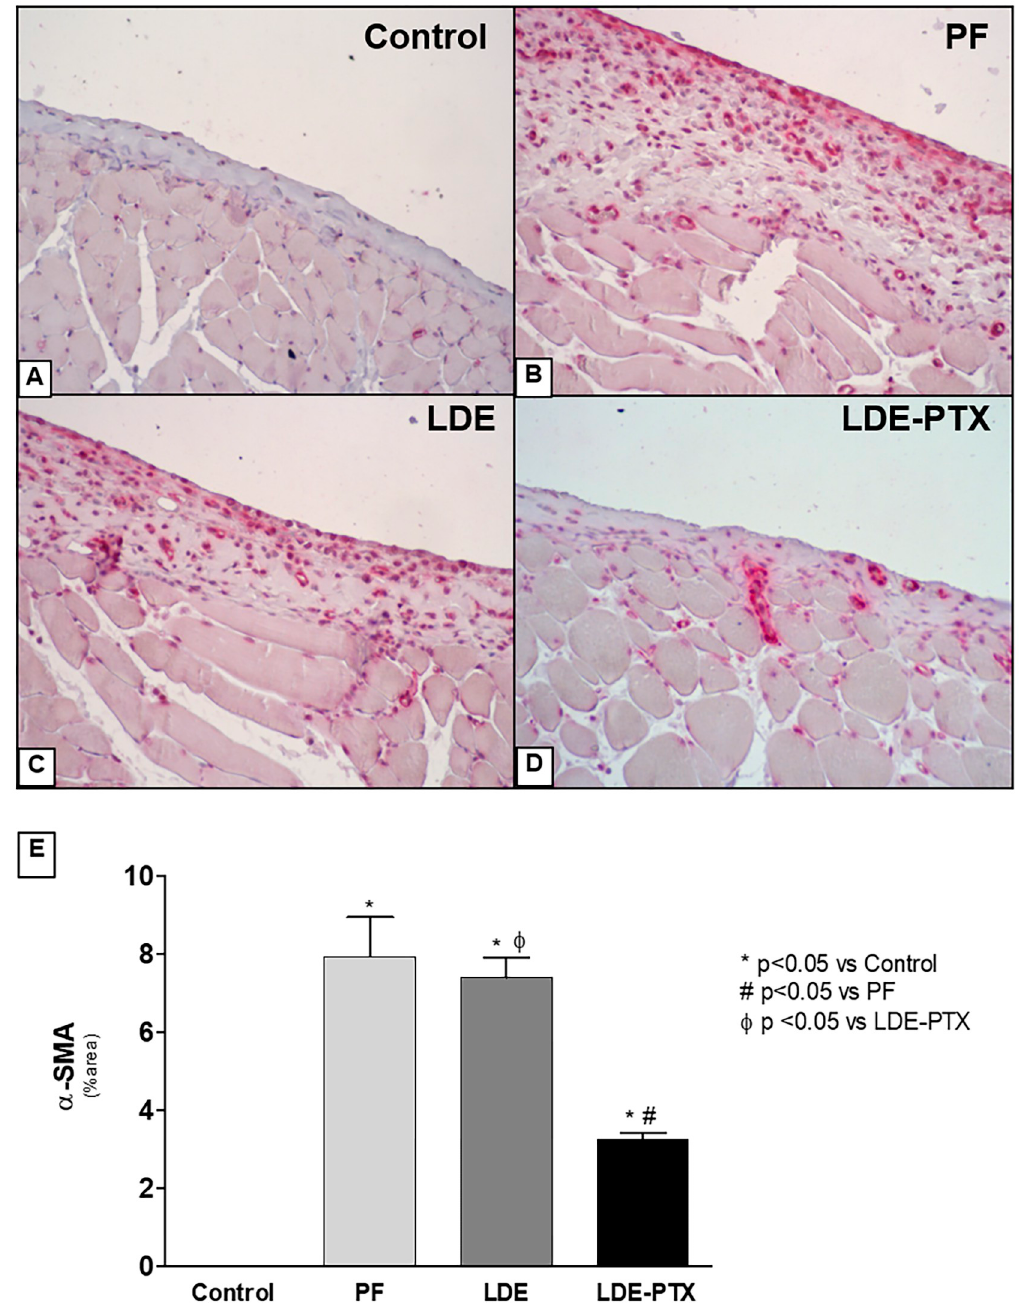
Fig 3. LDE-PXT treatment on α -SMA expression. Representative photomicrographs of peritoneal membrane samples stained for anti-rat α -smooth muscle actin ( α -SMA) using immunohistochemistry (x200). (A) The Control group (n = 5) showed no expression of α -SMA. (B) The PF (n = 5) and (C) the LDE groups (n = 8) showed a significant increase in α -SMA expression. (D) PF+LDE-PXT group (n = 8) exhibited an important reduction of α -SMA expression demonstrated by quantitative analysis (E) . � p < 0.01 vs Control; # p < 0.05 vs PF; F p < 0.05 vs LDE-PTX.